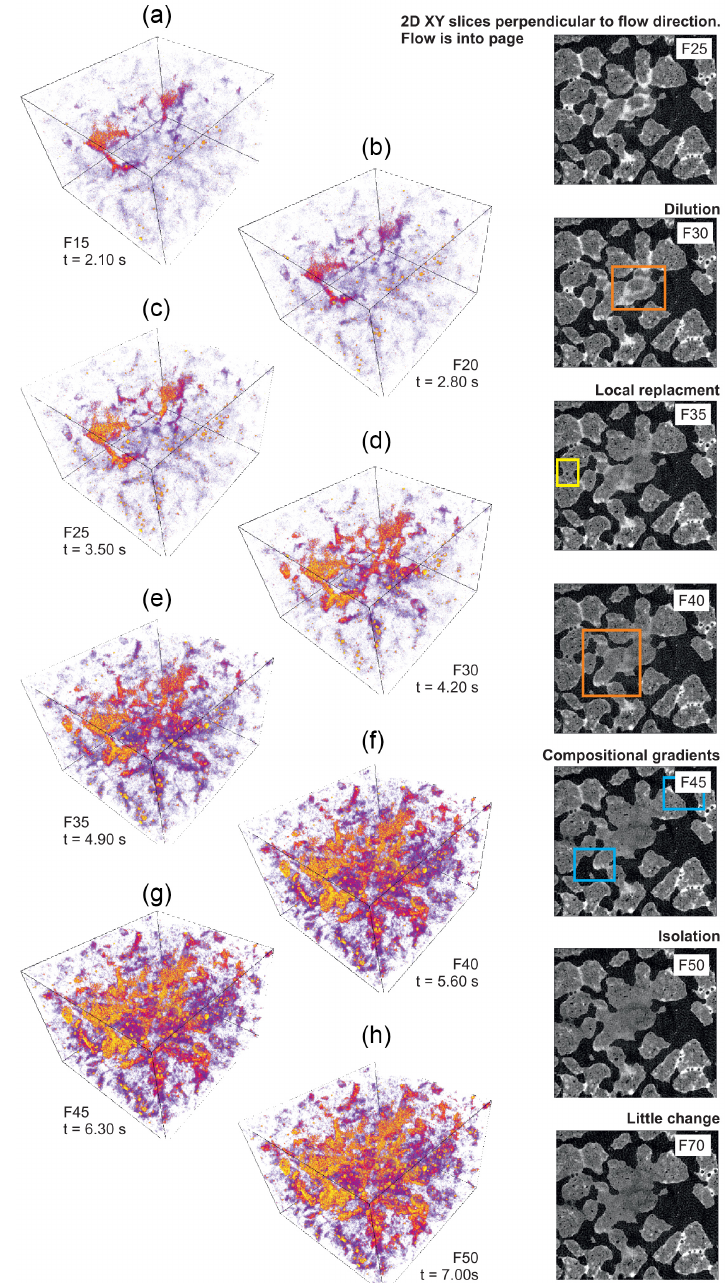
Figure 8. In situ observation of dilution. The 6M saline solution feed is replaced by H 2 O at t = 0. (a–h) Three-dimensional renders of the differential density (greyscale) between the initial saline fluid volume and the saline + water mixture at the times shown. The frame acquisition rate was 0.07s and acquisition frequency was 7Hz (g) . Data are from sample LD_3, scan 1. Yellow represents complete replace- ment with H 2 O. Cooler colours represent volumes that are undergoing dilution. Volumes remaining at 6M KI are not shown, as they have undergone no